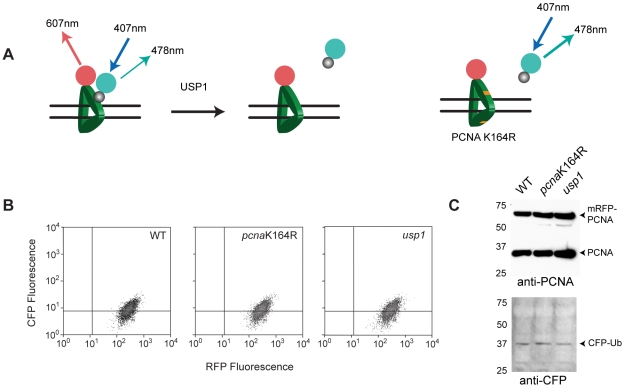
Expression of fluorescently tagged PCNA and ubiquitin in DT40 cells.A. The genetics of PCNA monoubiquitination. PCNA is monoubiquitinated at lysine 164 by RAD6/RAD18. The monoubiquitin can be cleaved from PCNA by USP1. Thus, when ubiquitin is conjugated to PCNA, FRET may take place between the CFP attached to ubiquitin and mRFP attached to PCNA. No FRET should be seen in a pcnaK164R cell line and the signal should be exaggerated in a usp1 line. B & C Expression of CFP-ubiquitin and mRFP-PCNA in DT40. B. FACS plots. C. Western blots.